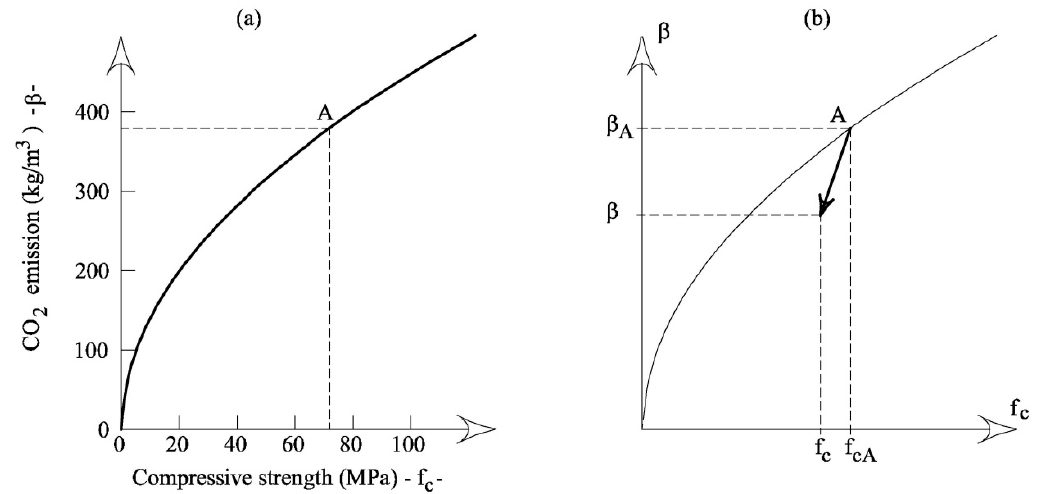
Figure 1. The impact of concrete: ( a ) the quadratic function proposed by Habert and Roussel [4]; ( b ) the decrement of β and f c due to the substitution of cement with fly ash in a specific concrete system, whose initial values of CO 2 emission and average compressive strength are β A and f cA , respectively.